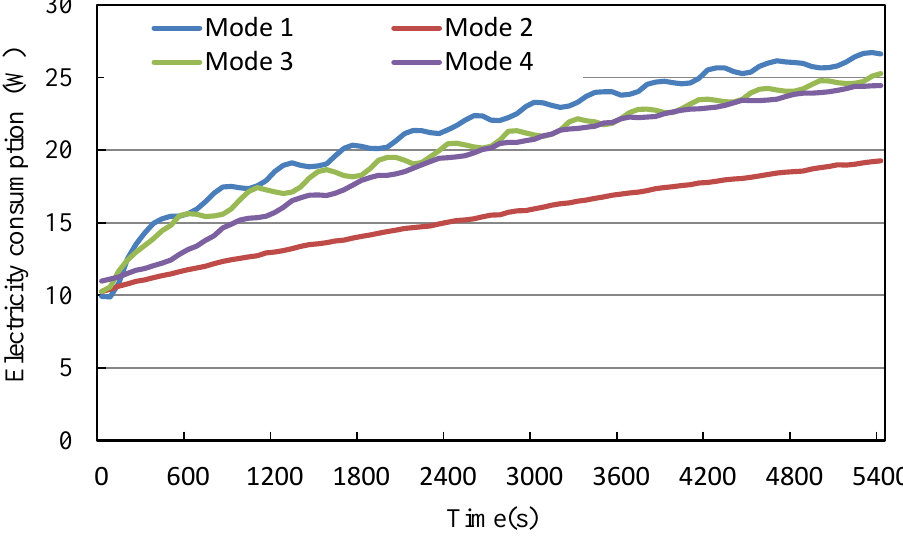
Figure 13. Electricity consumption of each operating mode.